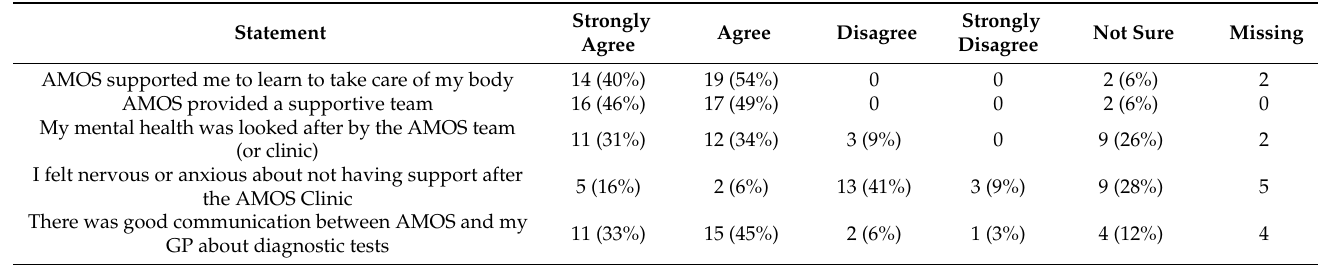
Table 2. Patient survey results—Theme 2: specialised multidisciplinary care.